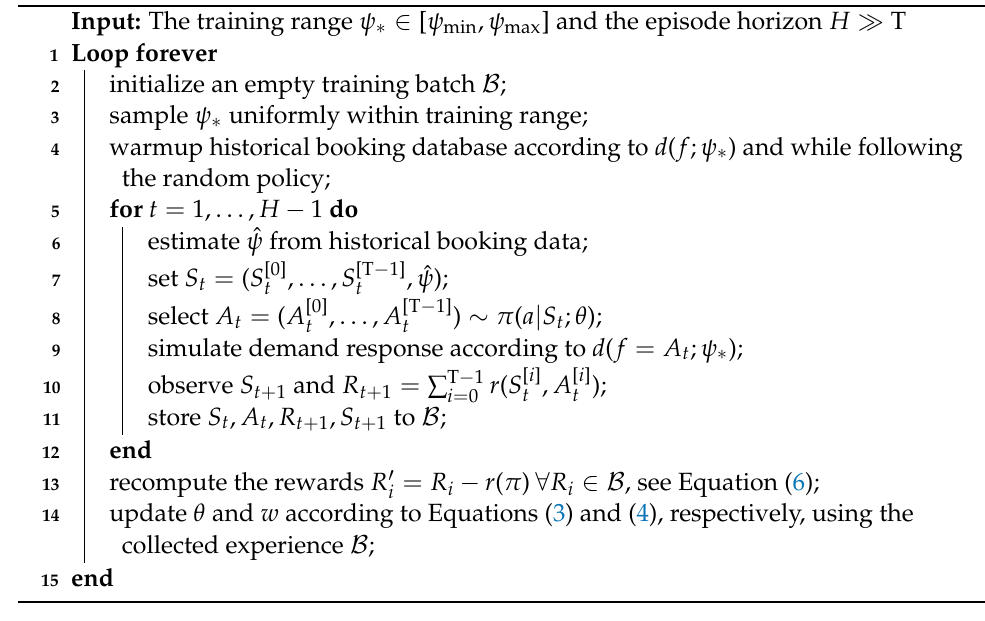
Algorithm 1: Actor–critic for